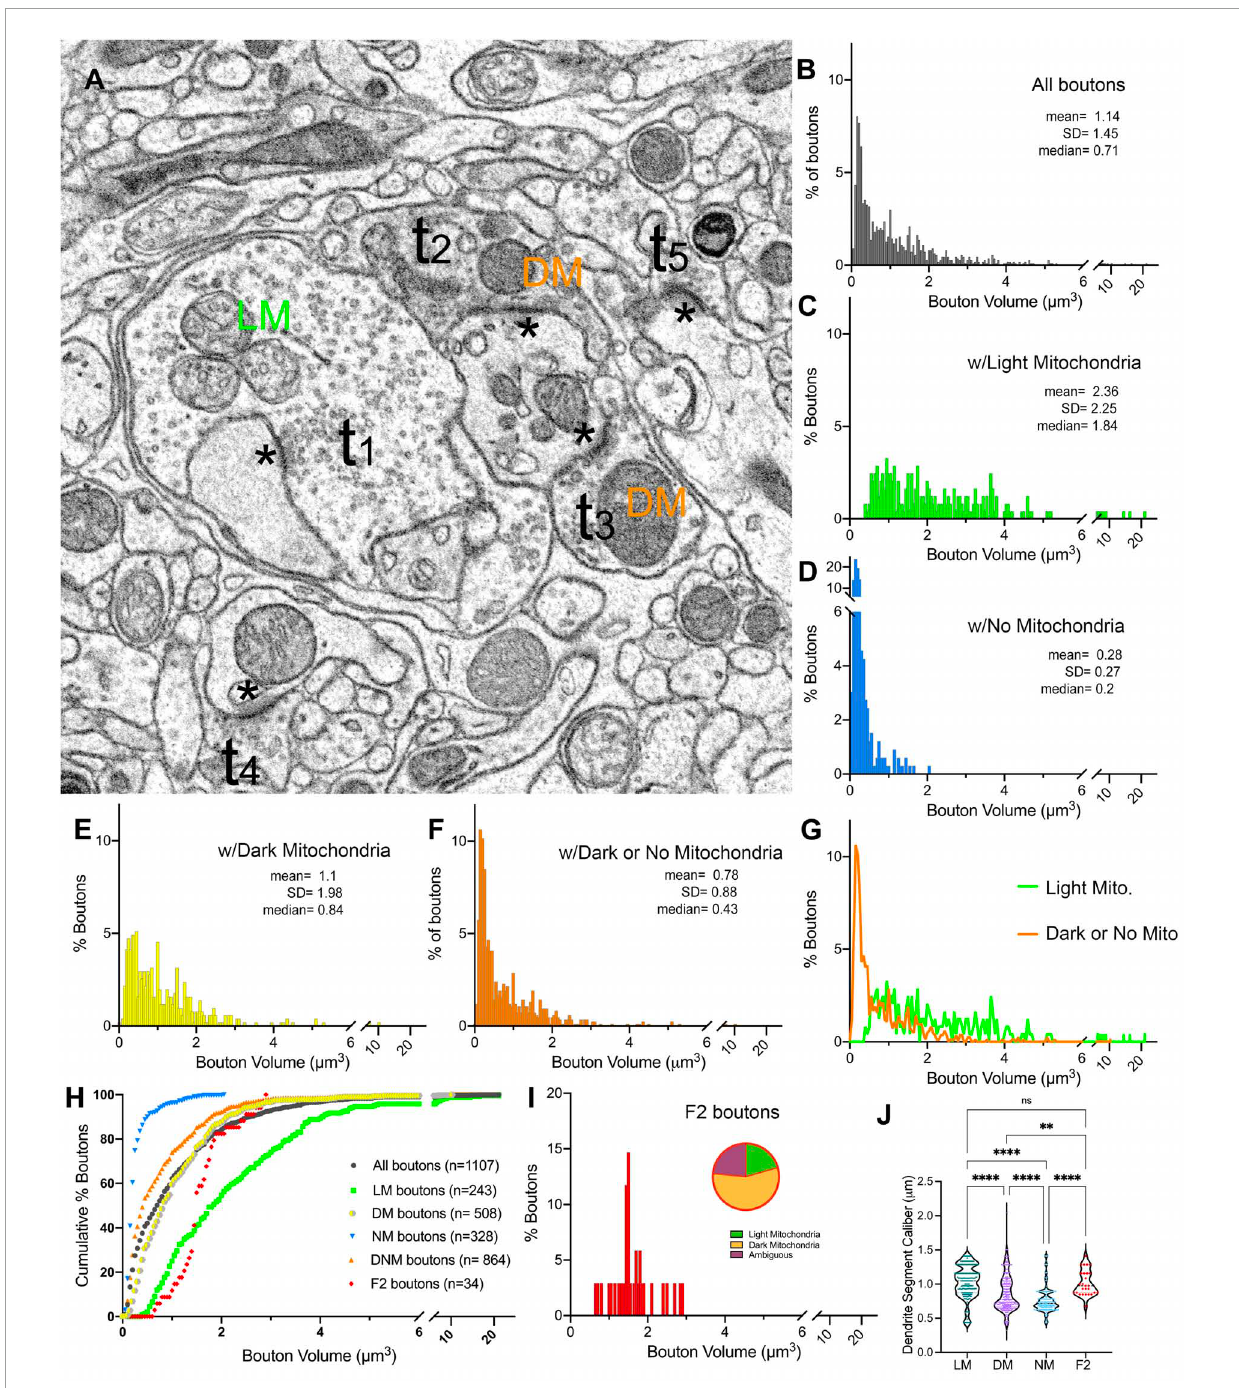
FIGURE4 Terminal boutons that synapse on relay dendrites. (A) Reconstructed boutons are initially classified as belonging to light-mitochondria (LM; t1) or non-LM or DNM (i.e., those with DM or No mitochondria; t2-t3) populations. While smaller terminals may contain no mitochondrion within the cross-section (e.g., t4, t5) or the reconstructed bouton, when followed up through the image stacks, these almost always emerge from axons containing dark mitochondria. The symbol * marks the postsynaptic sites. (B–F) Volume distribution histogram of all boutons (B) , and boutons with light mitochondria (C) , with no mitochondria (D) , with dark mitochondria (E) , and with dark or no mitochondria (F) . Mean, SD and median values are in µ m 3 . (G) The frequency distributions of larger-sized DNM and smaller-sized LM boutons overlap. (H) Cumulative percentage plot of all boutons, those with light mitochondria, dark mitochondria, no mitochondria, dark and no mitochondria combined, and the boutons that displayed pre- and postsynaptic morphology (i.e., F2 boutons). Except for LM vs. F2 boutons, all pairwise comparisons of distributions were statistically different ( p < 0.0001; Kruskal–Wallis, followed by Dunn’s multiple comparisons test). (I) Volume distribution of F2 terminals reveals these overlap both with LM and DNM populations. Note that the mitochondria in about half of F2 boutons could not be unambiguously classified as dark, and some had light mitochondria (inset pie chart). (J) The comparison of dendrite caliber among dendrite segments that form synapses with each type of morphologically classified bouton (Kruskal–Wallis followed by Dunn’s multiple comparisons test). ∗∗ p = 0.0029; ∗∗∗∗ p <